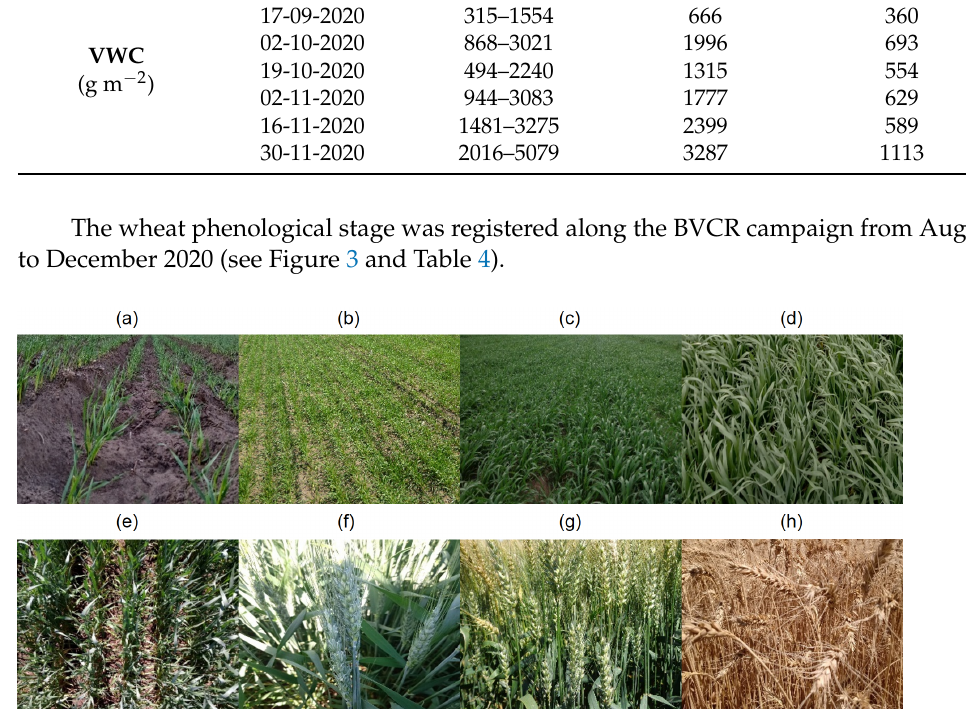
Figure 3. Photographic documentation of wheat crop growing period from August to